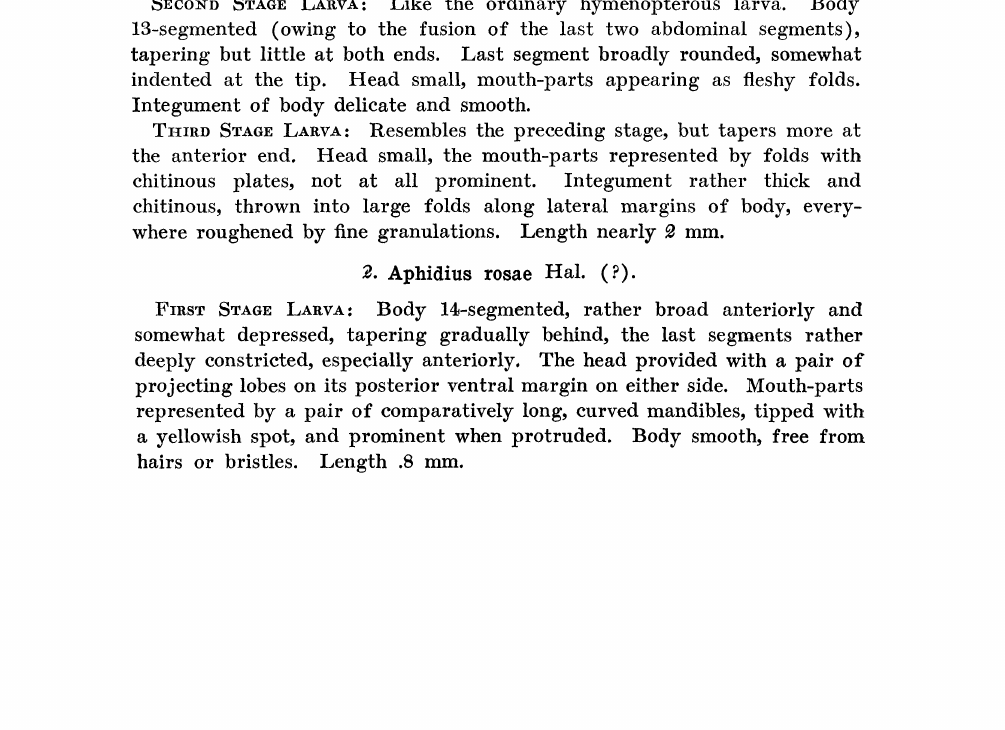
Fig. 1. Praon simulans Prov. 1, First Stage Larva; 2, Second Stage Larva 3, Third Stage